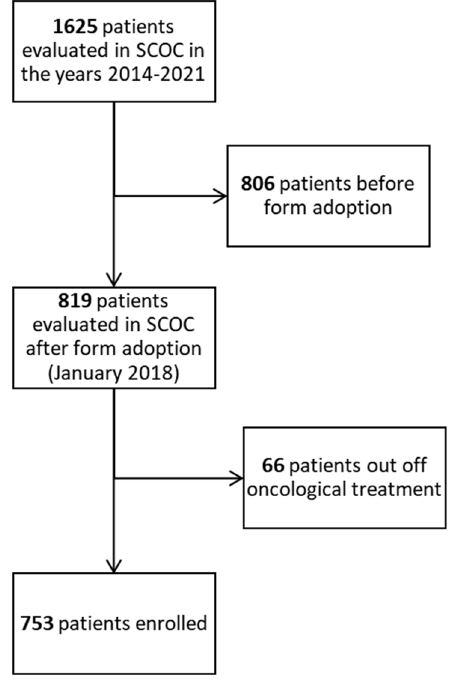
Figure 2. Flow chart of the study.